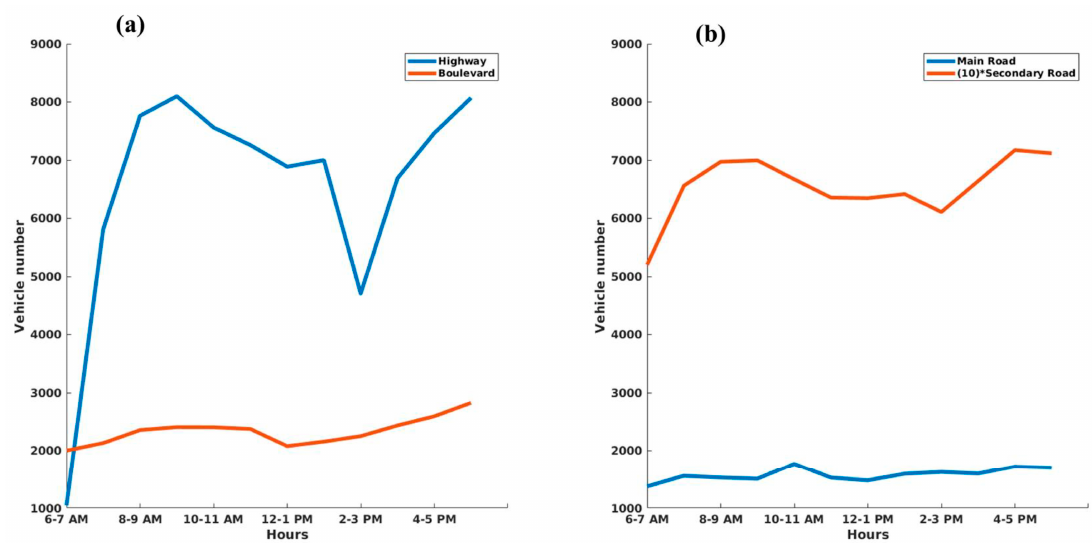
Figure 5. Average total traffic flow per highway and boulevard ( a ); main road and secondary road ( b ).